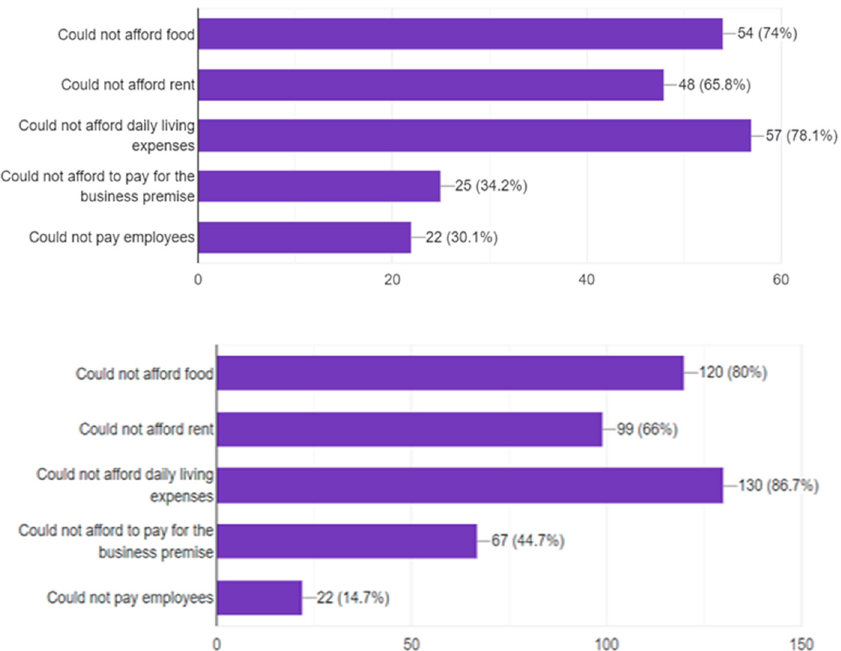
Figure 3. Impact of the Pandemic on the Livelihoods of Informal Workers. Source: Author’s own.